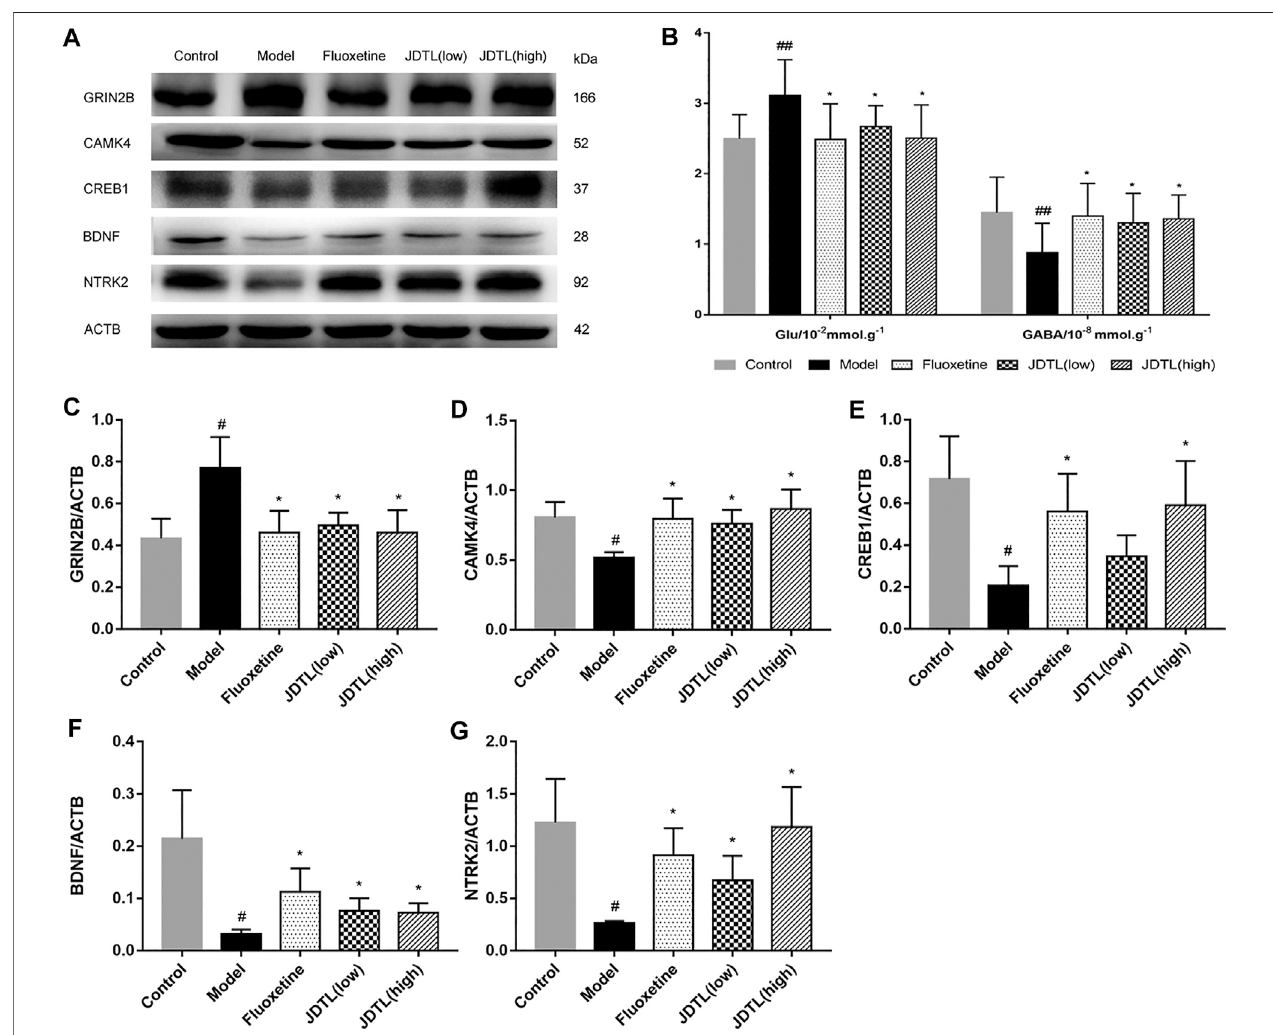
FIGURE7| JDTLGranulesInhibitsGRIN2BandActivatesBDNFPathwayinIpsilateralCortex. (A,C – F) RepresentativeimmunoblotsofGRIN2B,CAMK4,CREB1, BDNF,andNTRK2inallrats ’ ipsilateralcortex( n (cid:2) 3). (B) ThechangesinGluandGABAlevelsofbraintissues( n (cid:2) 10).Dataaredescribedasmean ± SD. # p < 0.05, ## p < 0.01 vs. control group. * p < 0.05 vs. model